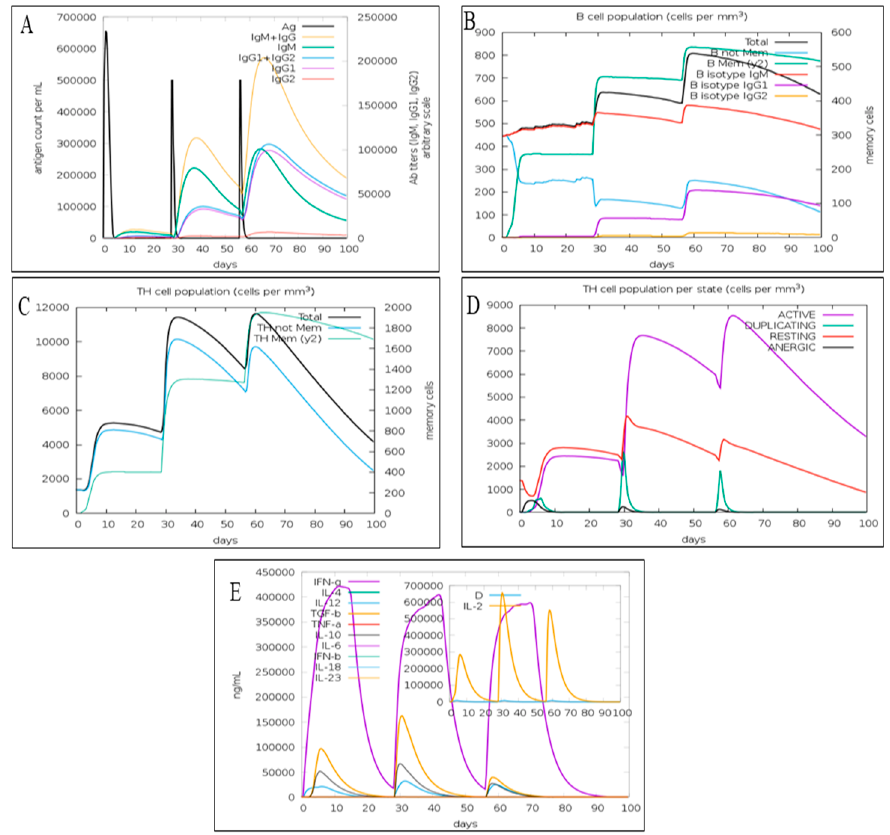
Figure 5. The immune response predicted using C-IMMSIM ( A ) antigen count and antibody titer with specific subclass; ( B ) B cell; ( C ) CD4 + T cell; ( D ) CD4 + T cell population per state; ( E ) cytokines and interleukins.